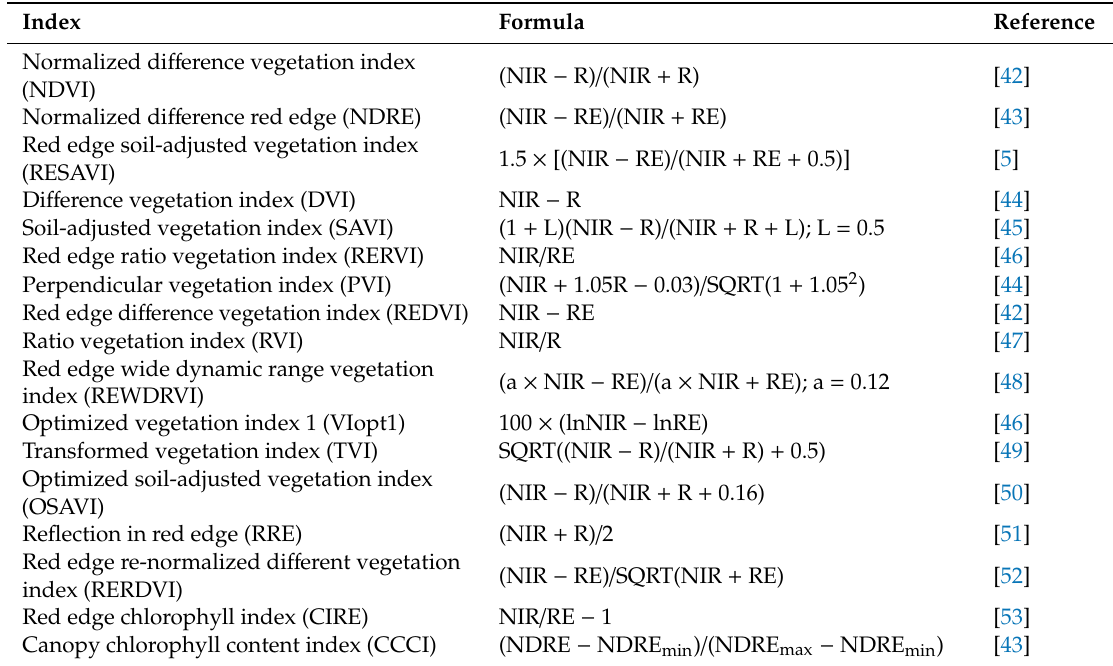
Table 2. Vegetation indices used for the RapidSCAN CS-45